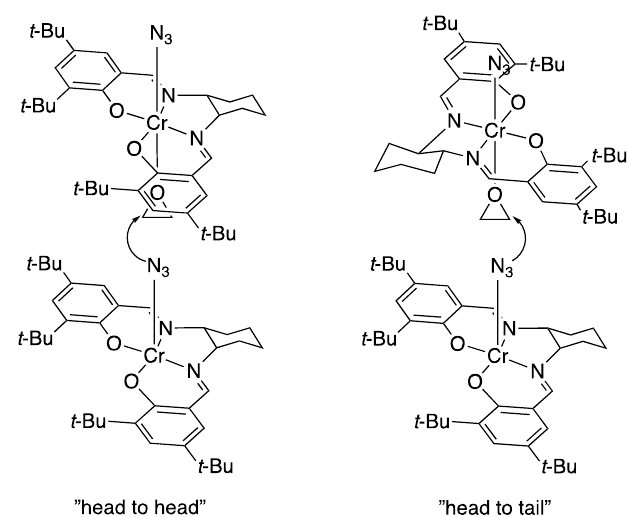
Figure 2. The two limiting geometries for the enantioselectivity-determining transition state of the asymmetric ring-opening of meso -epoxides catalyzed by Cr–salen complex 2 as proposed by Jacobsen et al. [30] .